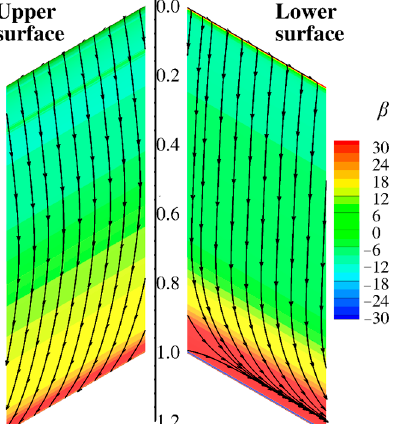
Figure 9. Averaged surface streamlines of the smooth wing.